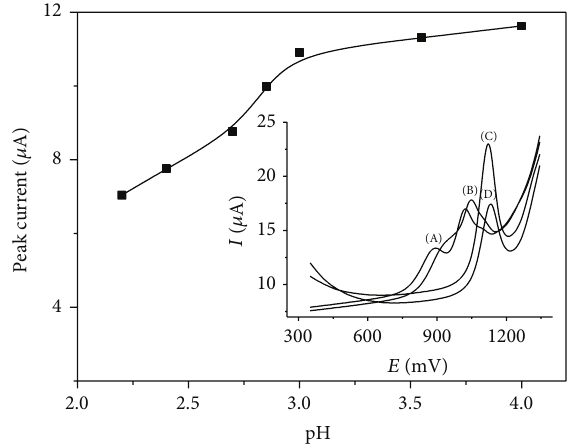
Figure 7: Dependence of the peak current on pH (2.2; 2.4; 2.7; 2.8; 3; 3.6; 4.0) for 10 𝜇 M codeine in 0.1M phosphate buffer and volume of Nafion/MWCNTs 10 𝜇 L and obtained voltammograms for (A) 8.0; (B) 7.5; (C) 3.0; (D) 2.2 pH. All other conditions are as in Figure